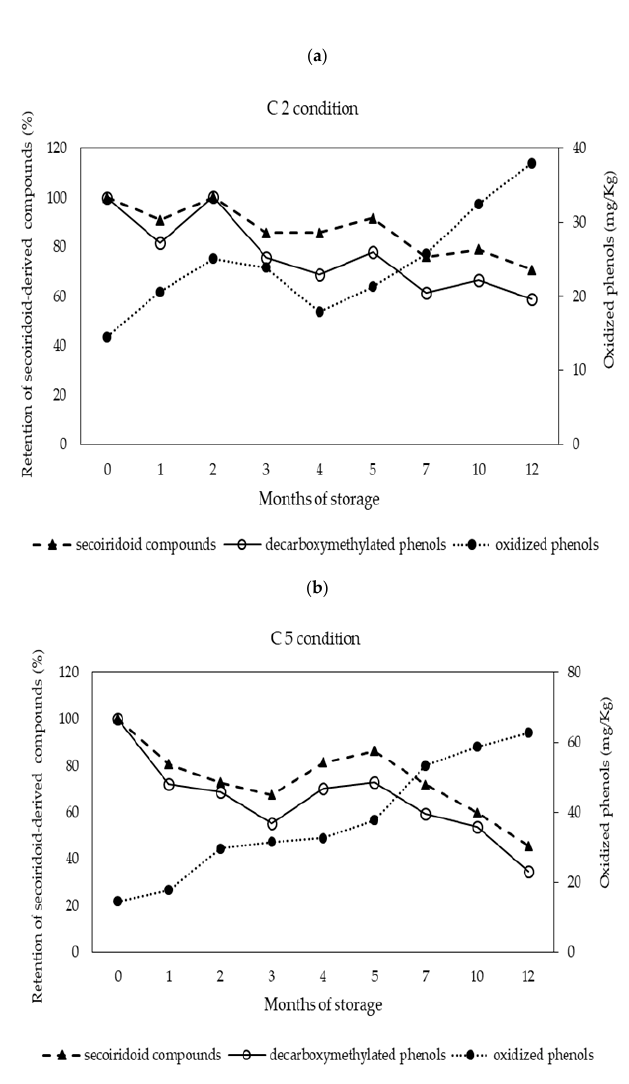
Figure 2. Evolution of secoiridoid compounds, decarboxymethylated phenols, and oxidized phenols during 12 months of storage for the conditions (a) C2 (23 ± 2 °C, with light) and (b) C5 (40 ± 2 °C, in darkness).